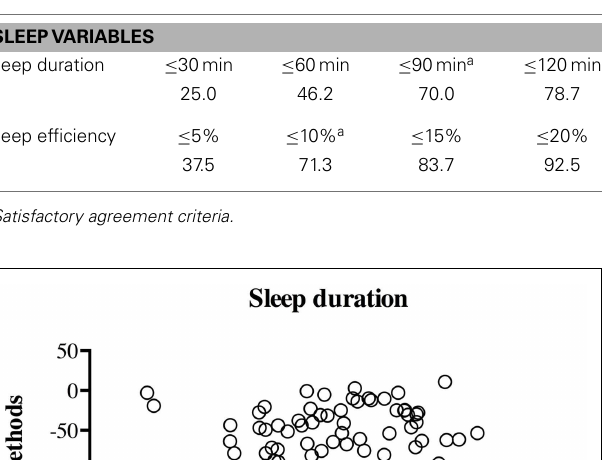
Table 4 | Spearman rank-order correlations between CBCL and actigraphy .